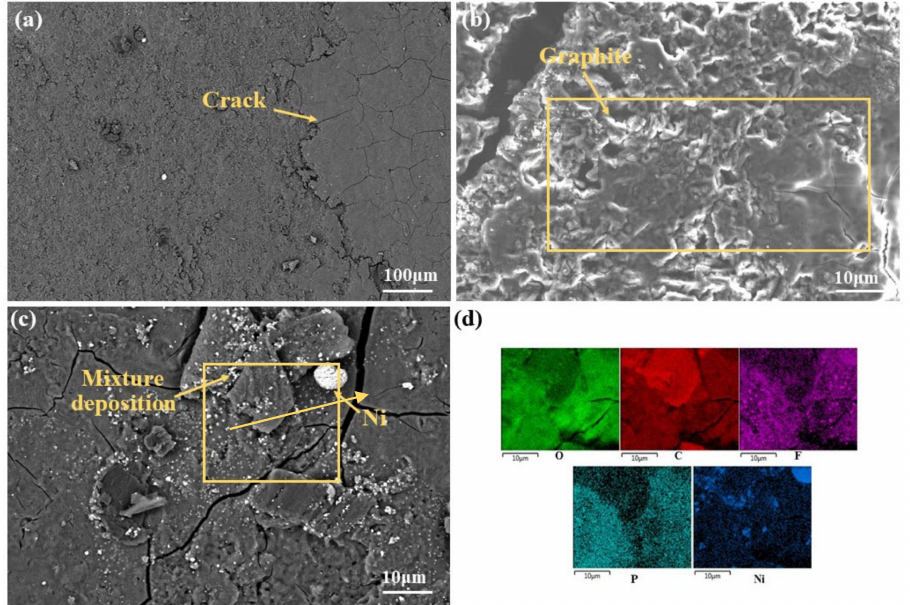
Figure 9. ( a – c ) SEM micrographs with different magnifications obtained from the negative electrode of a -type NCM811 battery after 130 cycles. ( d ) The EDS diagram of the marked part from ( c ).